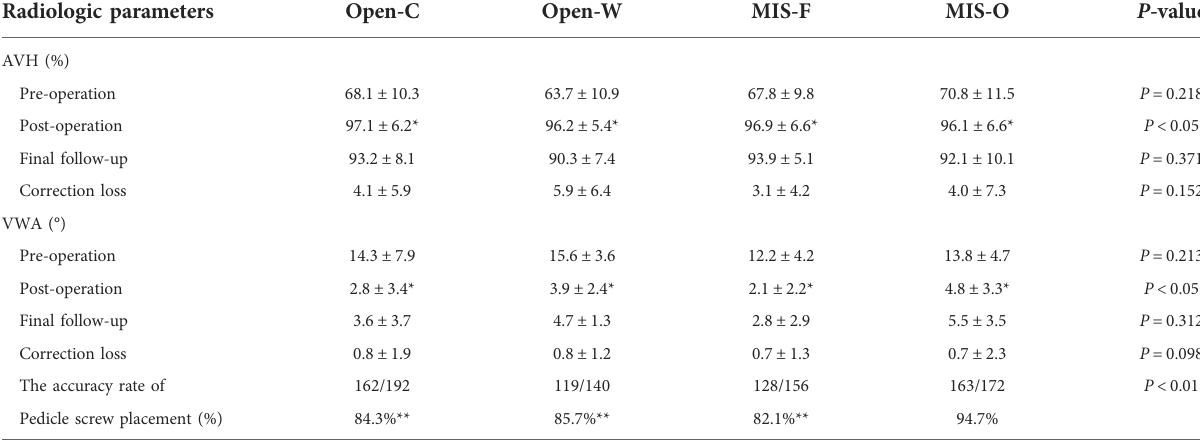
TABLE 4 Radiologic parameters including AVH, VWA and accuracy of pedicle screw placement of the four